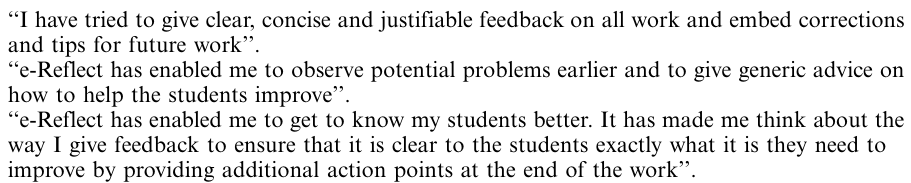
Table 3. Staff comments on the MAC